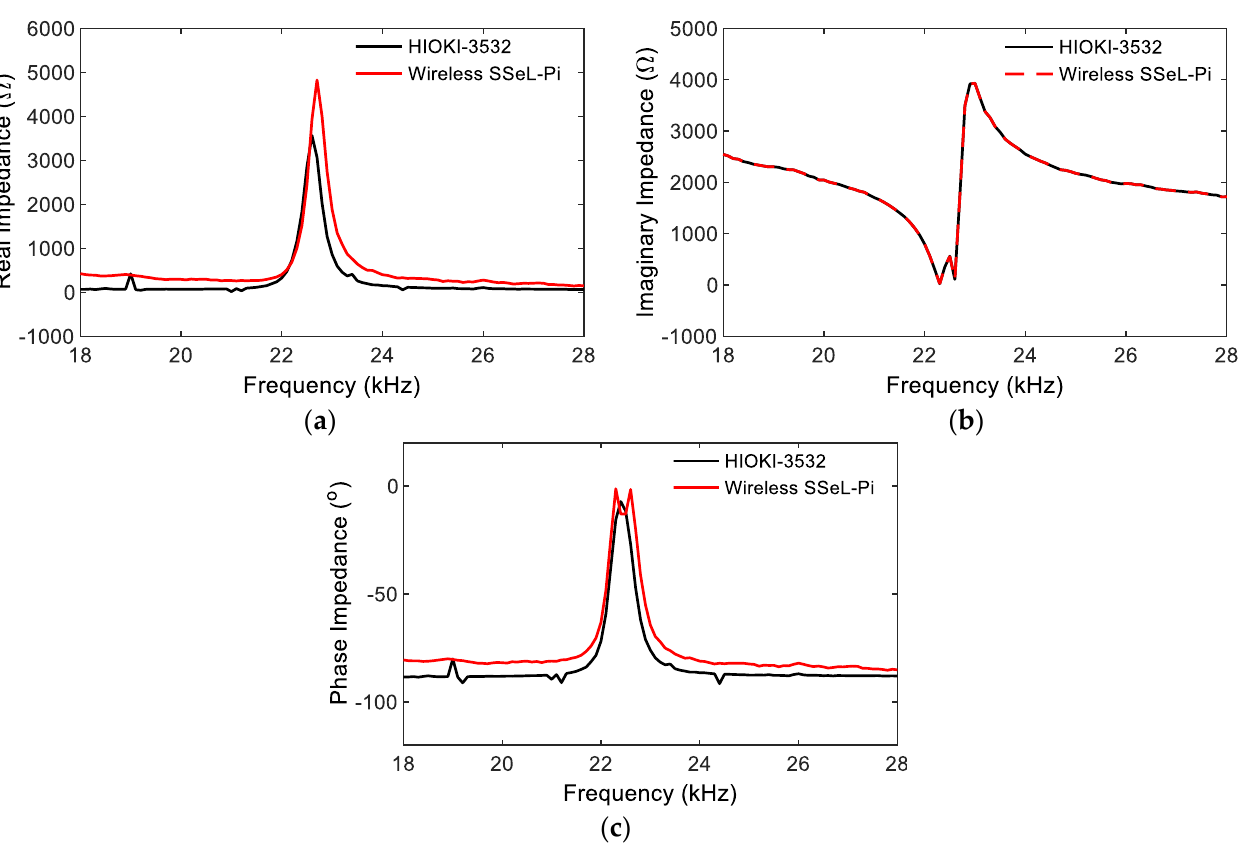
Figure 16. Regression models for impedance phase angle and gain factor. ( a ) Phase fit j factor fit G 2 .